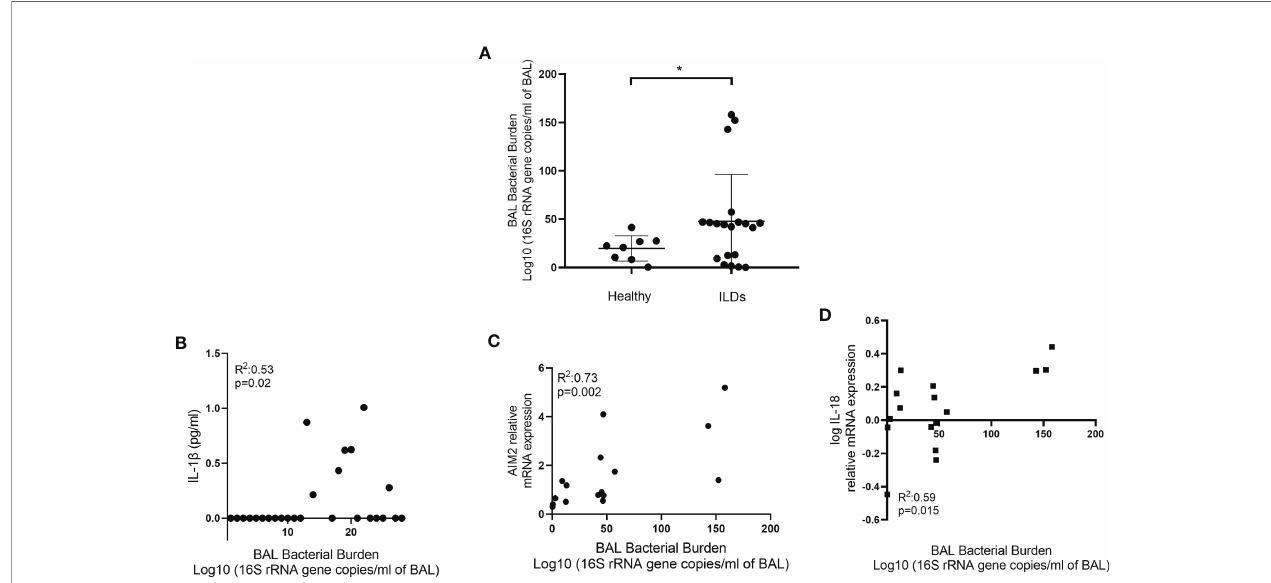
FIGURE 5 | Bacterial burden and the in fl ammasome. (A) Bacterial burden in bronchoalveolar lavage (BAL) of healthy and ILD subjects. Bacterial burden calculated by qPCR and expressed as log10 (16S rRNA gene copies/ml of BAL). Mann-Whitney test. Data are presented as median and interquartile range, *p<0.05. Illustrating correlation between bacterial burden and (B) IL-1 b release from AMs (Spearman correlation) and (C) AIM2 and (D) IL-18 log relative mRNA expression (Pearson